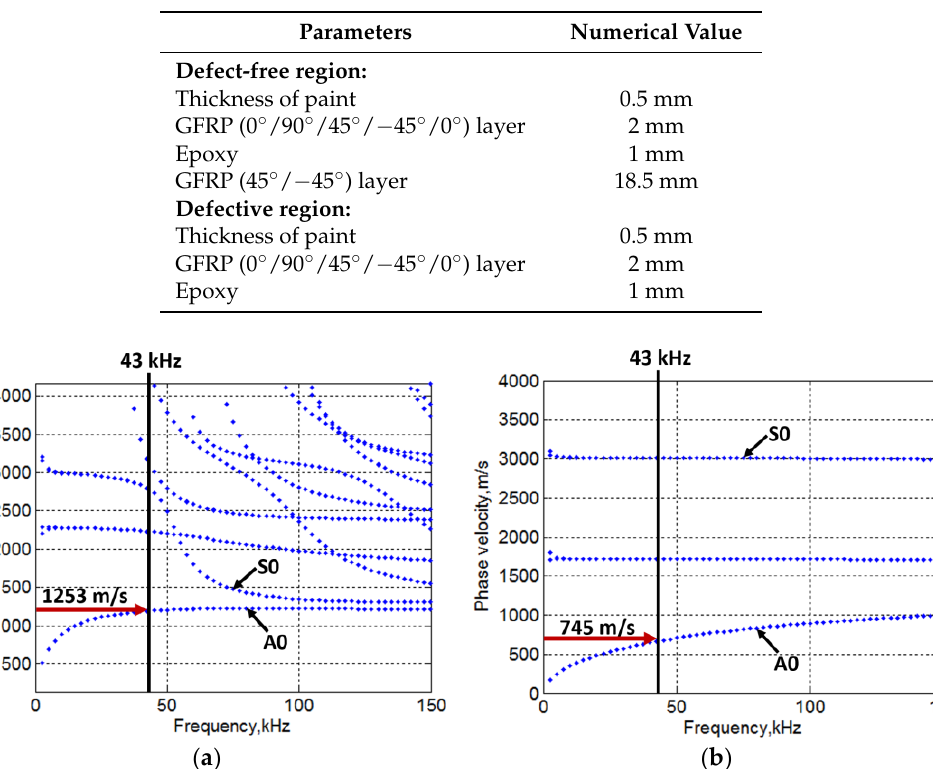
Table 3. The thickness of layers in defect-free and defective region.